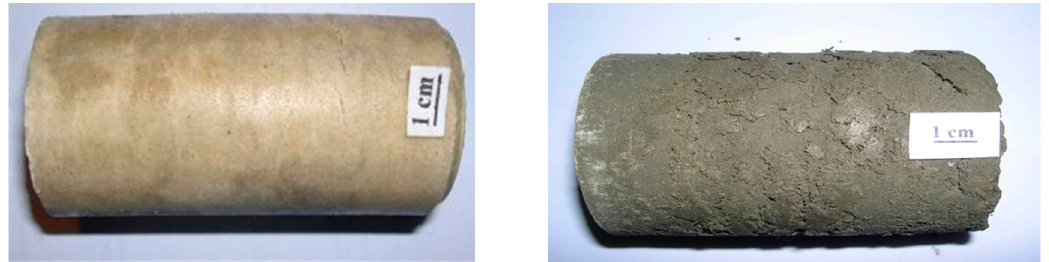
Figure 3. General view of frozen sand samples with pore hydrates and massive ice–hydrate texture (at − 6 to − 7 °C and 0.1 MPa).